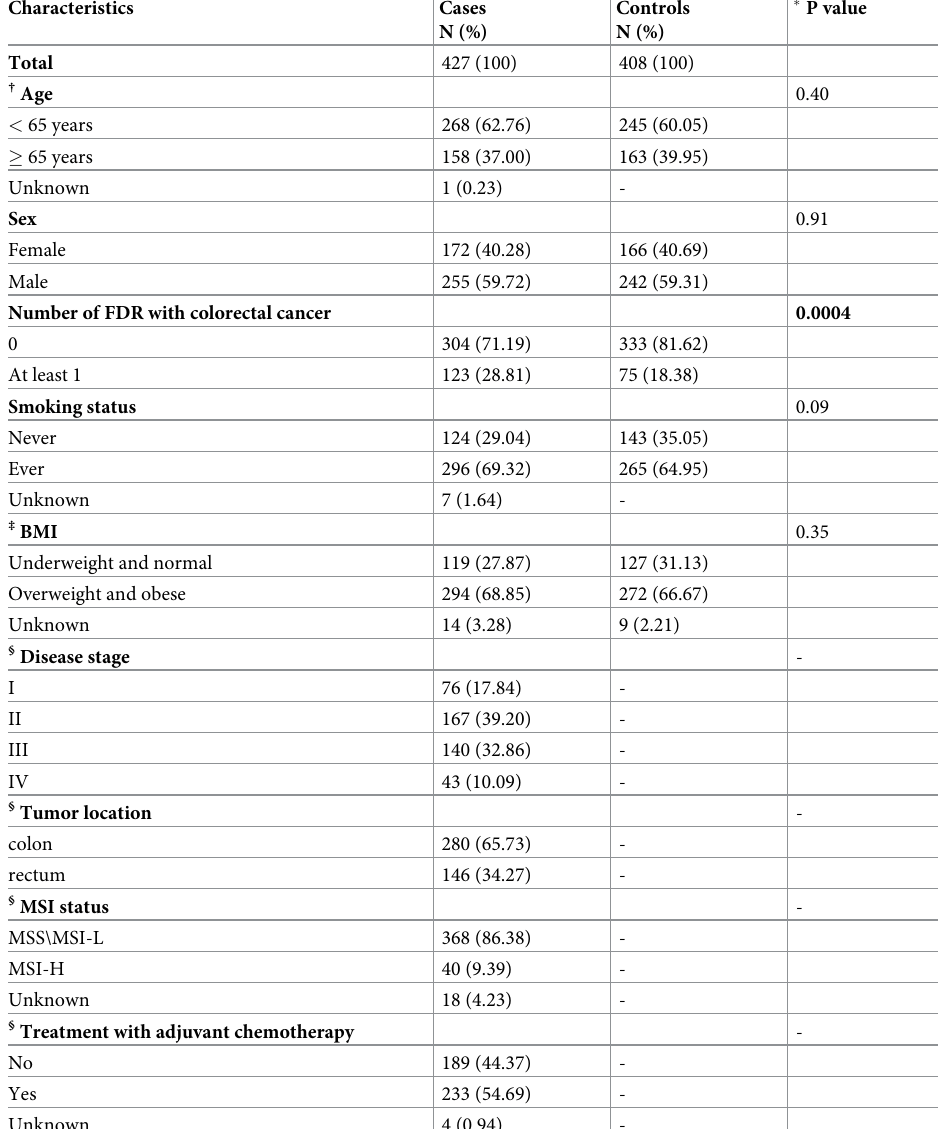
Table 1. Distribution of baseline characteristics of the study cohorts.